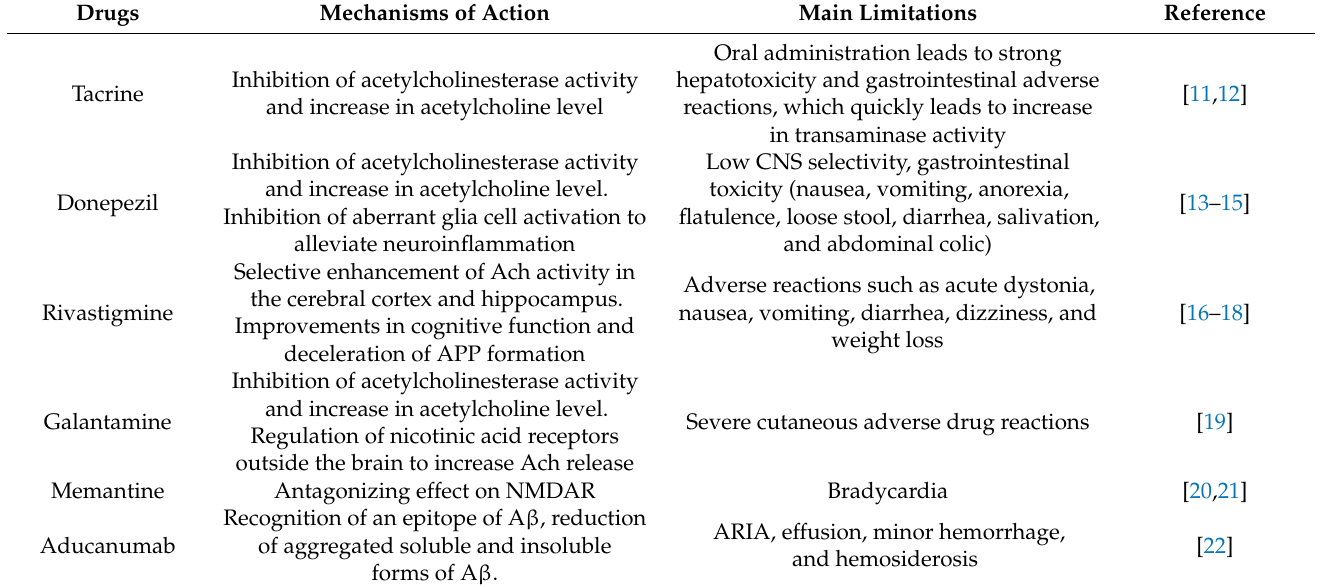
Table 1. The mechanisms of action and adverse reactions of drugs approved by Food and Drug Administration (FDA) for Alzheimer’s disease (AD)